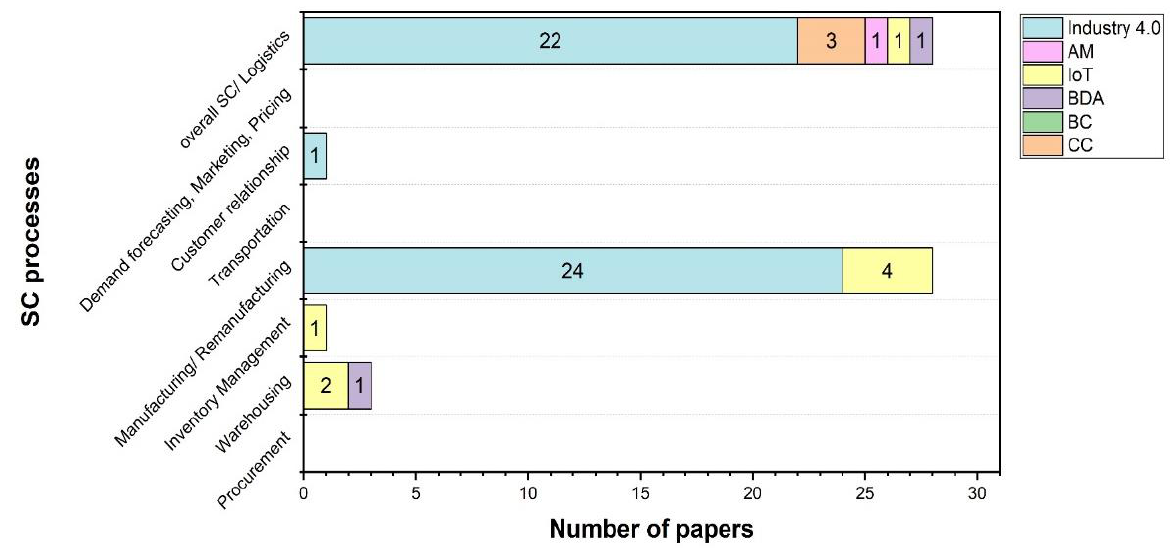
Figure 5. Distribution of papers: SC processes.